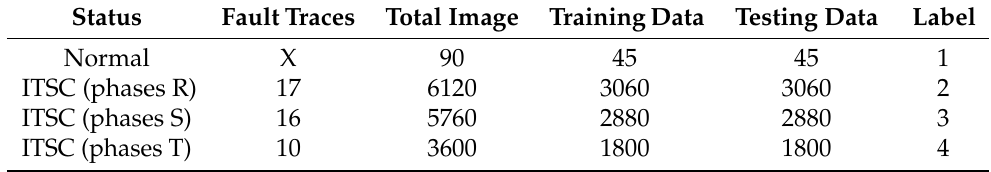
Table 3. The database.